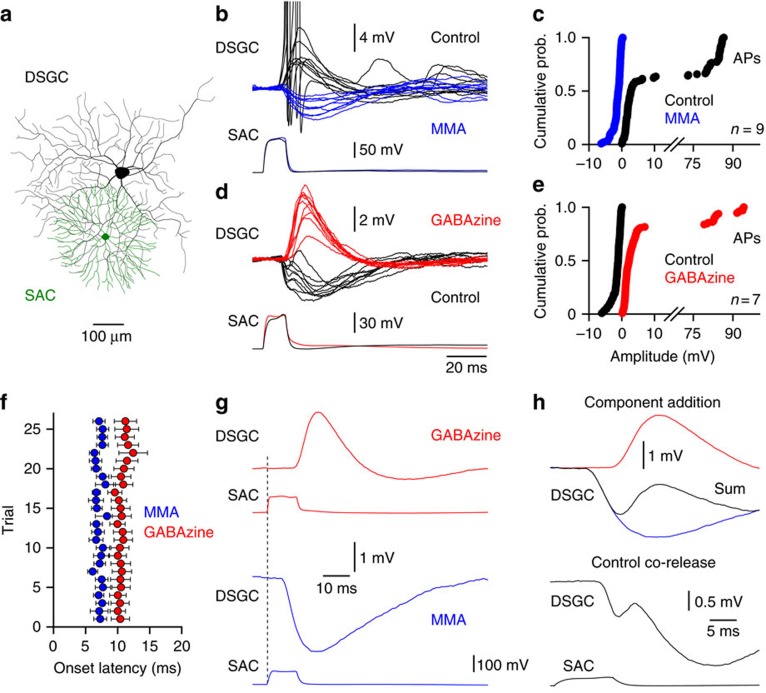
Starburst amacrine cell-mediated cholinergic excitation and GABAergic inhibition.(a) Reconstruction of a connected pair of ON-SAC (green) and ON-DSGCs (black). (b) Paired recording revealed the obligatory co-release of ACh and GABA from ON-SACs. Overlain voltage traces show the transformation of SAC-driven synaptic excitation of an ON-DSGC to synaptic inhibition when nAChRs were blocked with Mecamylamine (MMA, 10 μM, blue traces; action potentials (APs) have been truncated for clarity). The lower traces show the somatic current-evoked excitation of the ON-SAC. (c) Cumulative probability distributions of the amplitude of each SAC-evoked PSP recorded under the indicated conditions, from the indicated number of paired recordings. (d) In a different pair of ON-SAC and ON-DSGCs net inhibition was generated under control conditions, which was transformed to excitation by the blockade of GABAA receptors (SR-95531 (GABAzine), 10 μM, red; morphologies shown in a). (e) Cumulative probability distributions of PSP amplitude under the indicated conditions. (f) Onset latency of pharmacologically isolated excitatory and inhibitory PSPs, recorded in GABAzine (n=7) and MMA (n=7), respectively. Onset latency was measured from the onset of the presynaptic driving current to 5% of the peak of the postsynaptic response. (g) Averaged pharmacologically isolated excitatory and inhibitory PSPs, the vertical dashed line indicates the onset time of the presynaptic driving current. (h) Upper overlain traces show the biphasic waveform (sum, black trace) produced by the arithmetic summation of isolated excitatory and inhibitory PSPs. The lower trace shows an averaged PSP recorded under control conditions, note the biphasic waveform.